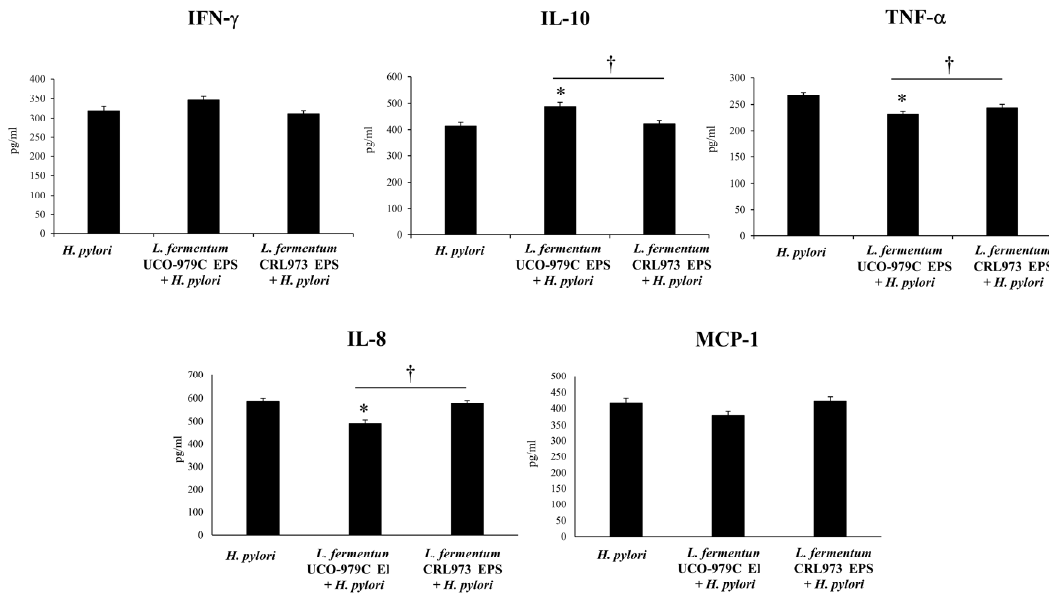
Figure 12. E ff ect of L. fermentum UCO-979C or L. fermentum CRL973 EPS on serum cytokines and chemokines in adult immunocompetent mice infected with H. pylori SS1. L. fermentum UCO-979C or L. fermentum CRL973 EPS were administered to di ff erent groups of mice for two consecutive days at a dose of 100 µ g / mL mouse / day, then mice were challenged with H. pylori SS1. Two days post-infection, serum concentrations of IFN- γ , IL-10, TNF- α , IL-8 and MCP-1 (pg / mL) were determined. Mice infected with H. pylori were used as controls. Results are expressed as mean ± standard deviation. Significant di ff erences when compared to the control group: * ( p < 0.05). Significant di ff erences when compared to the indicated group: † ( p <